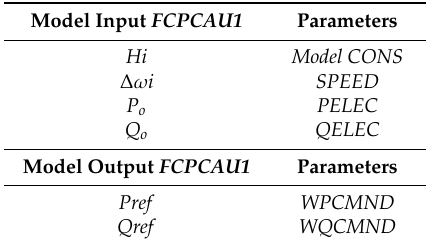
Table 3. FCPCAU1 Model Input and Output